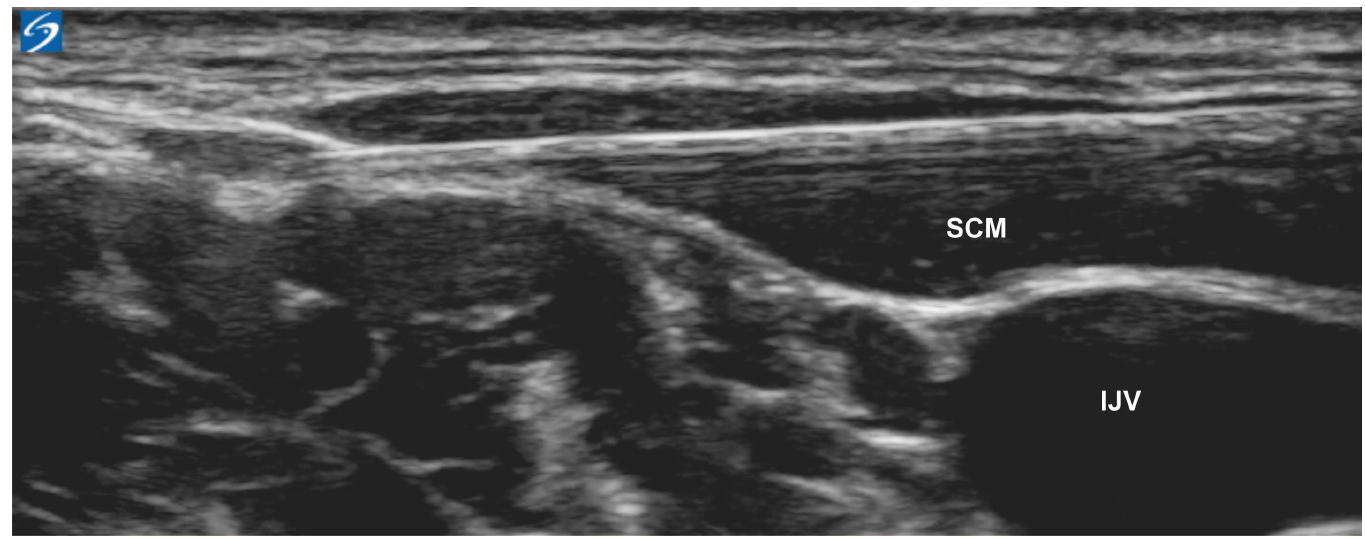
Fig 3. Ultrasound-guided superficial cervical plexus block. SCM: sternocleidomastoid muscle, IJV: internal jugular vein.